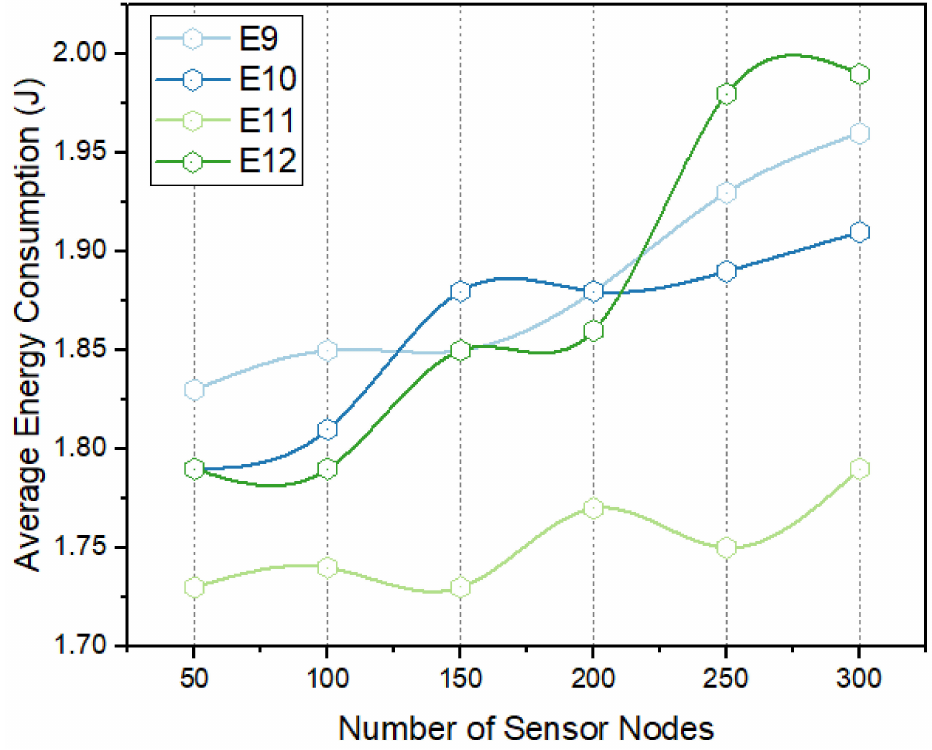
Figure 15. Energy-efficient routing schemes and